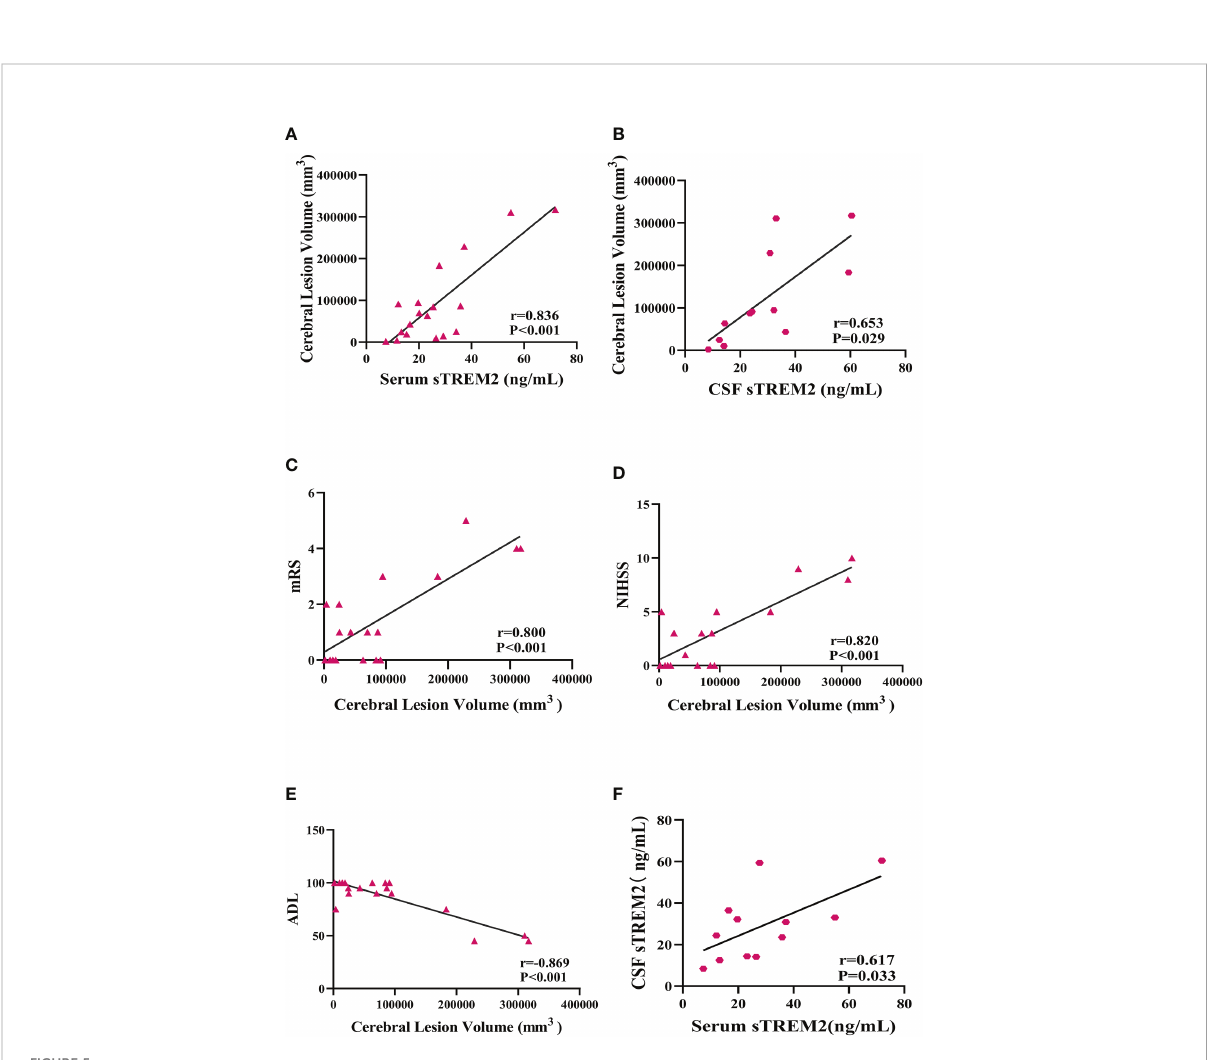
FIGURE 5 Serum and CSF sTREM2 levels were correlated with cerebral lesion volume in PACNS patients, and cerebral lesion volume was associated with mRS, NIHSS, and ADL scores. (A, B) Serum (n=18) and CSF (n=12) sTREM2 concentrations were signi fi cantly correlated with cerebral lesion volume analysed by partial correlation analyses after controlling for age. (C – E) The cerebral lesion volume in PACNS patients (n=18) was strongly correlated with the mRS, NIHSS, and ADL scores. (F) The serum (n=12) sTREM2 levels are positively correlated with CSF (n=12) sTREM2